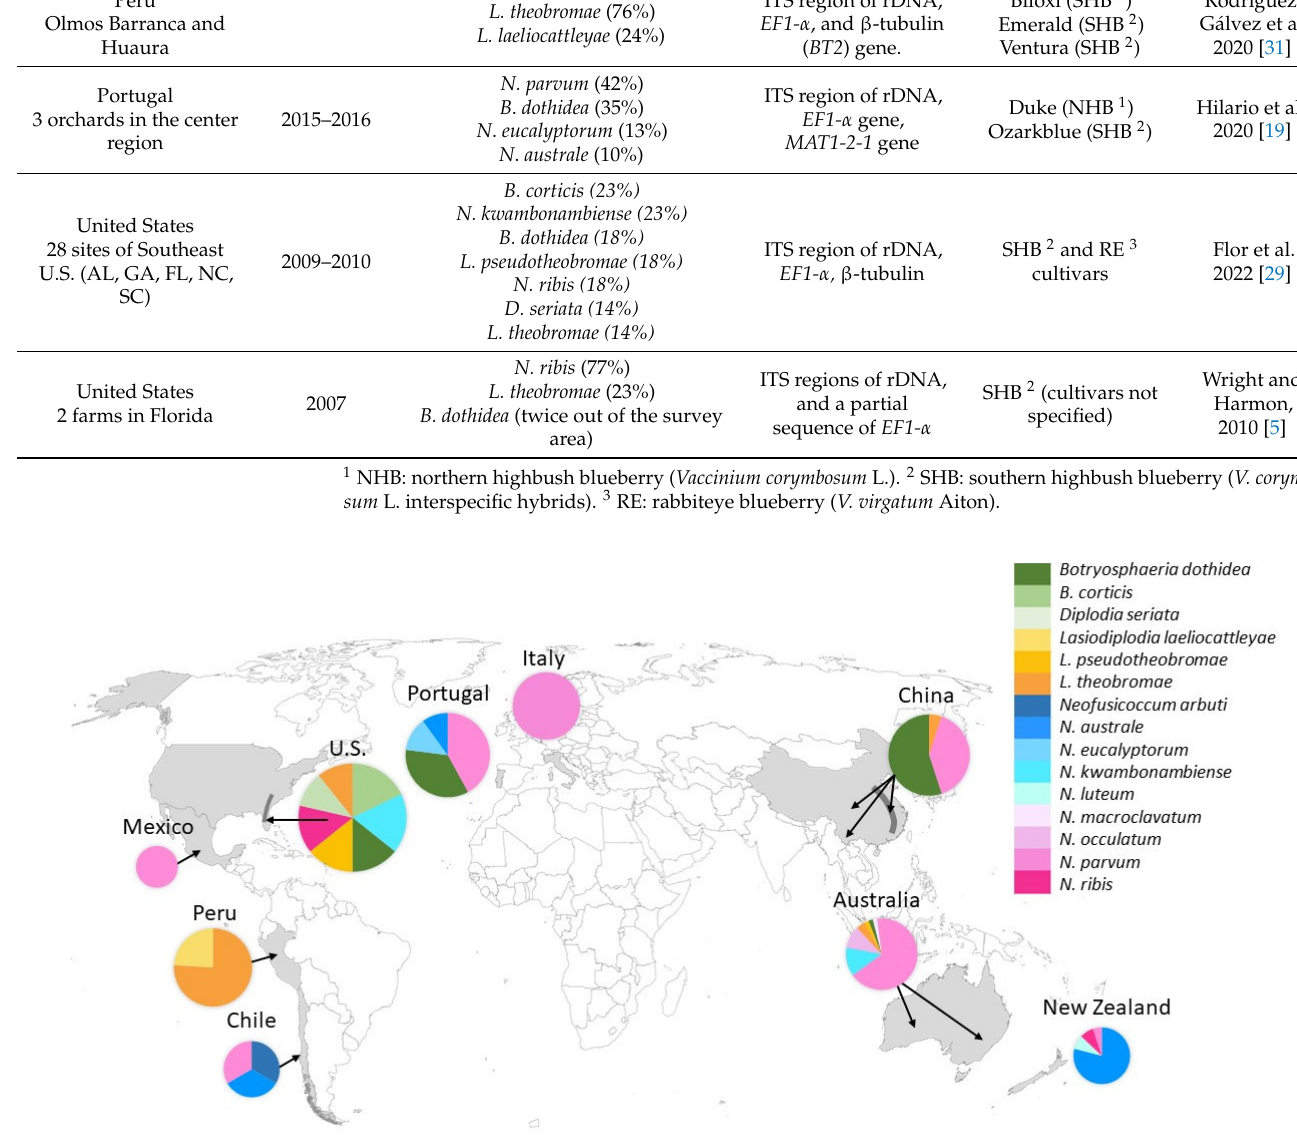
Figure 2. Worldwide distribution of causal pathogens of Botryosphaeria stem blight. Size of each pie chart indicates sample size in each study. Only studies which used DNA sequence information to identify causal agents were included in this figure. Detailed data can be found in Table 1 [6,15,17– 19,28–31].